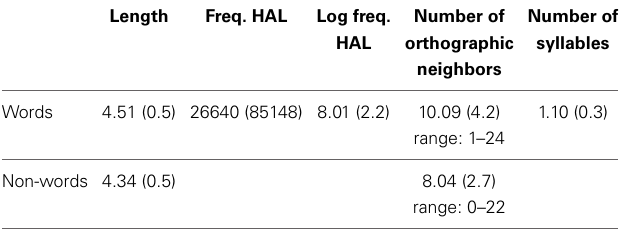
Table 3 | Lexical properties of neighbor knowledge test stimuli.